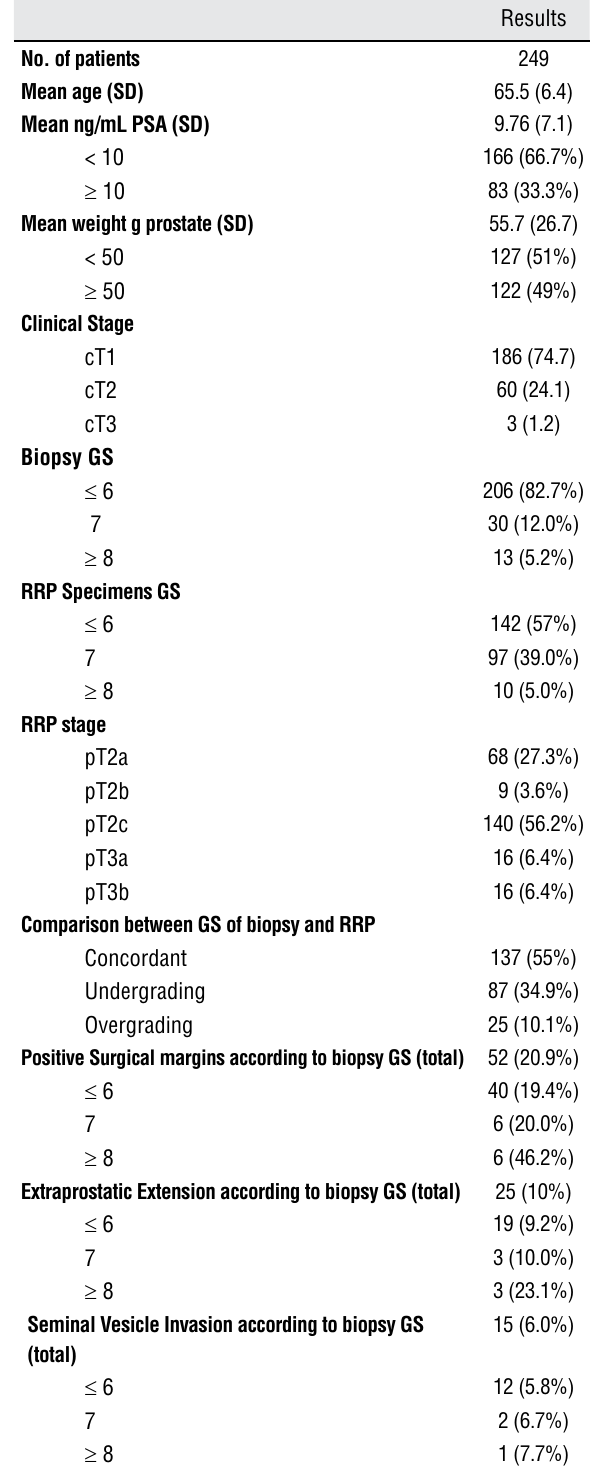
Table 1 - Baseline characteristics of 249 patients with single core